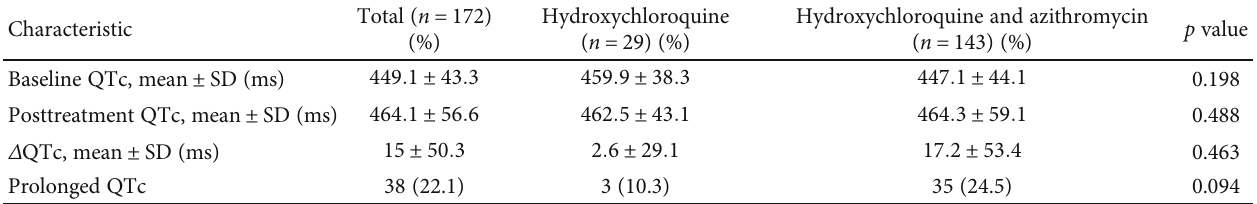
Table 2: Baseline and posttreatment QTc